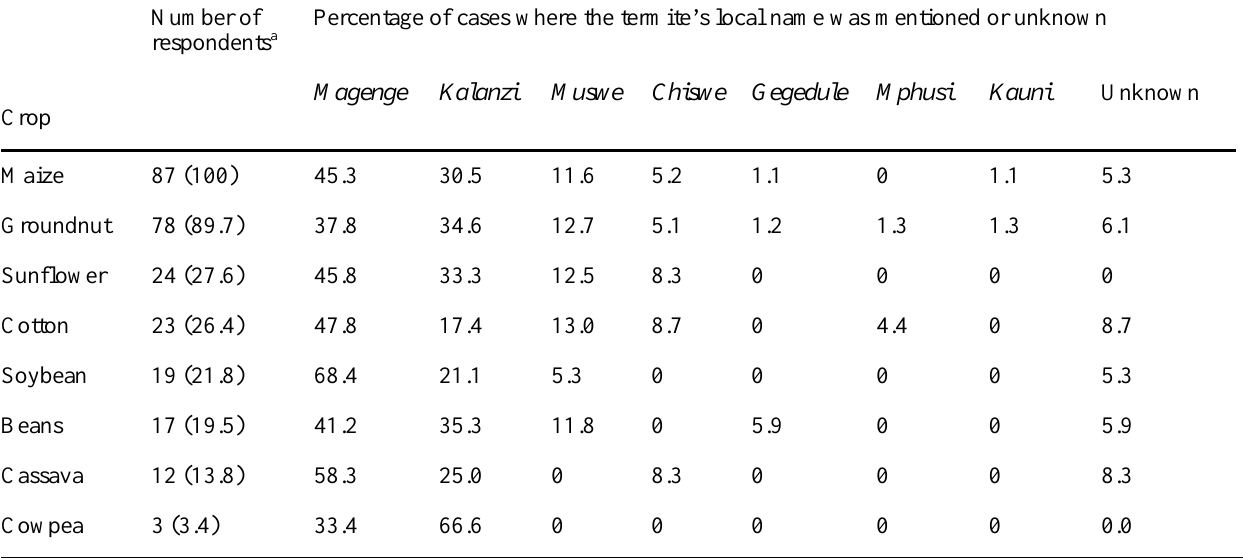
Table 2. Percentage of respondents identifying termites that attack crop plants by local names in eastern Zambia (source: Sileshi, unpublished data) Number of Percentage of cases where the termite’s local name was mentioned or unknown respondents a Magenge Kalanzi Muswe Chiswe Gegedule Mphusi Kauni Unknown Crop Maize 87 (100) 45.3 Groundnut 78 (89.7) Sunflower Cotton Soybean Beans